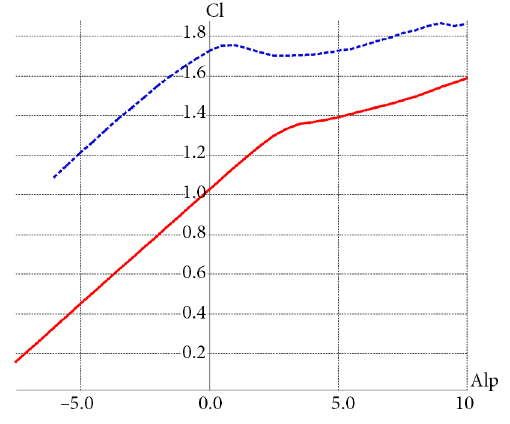
Fig. 6. Impact of the VGMF on the Cl and AoA of airfoil LAP 7-131/17 (Flap angle +15 deg.) (Figure: P. Lauk)